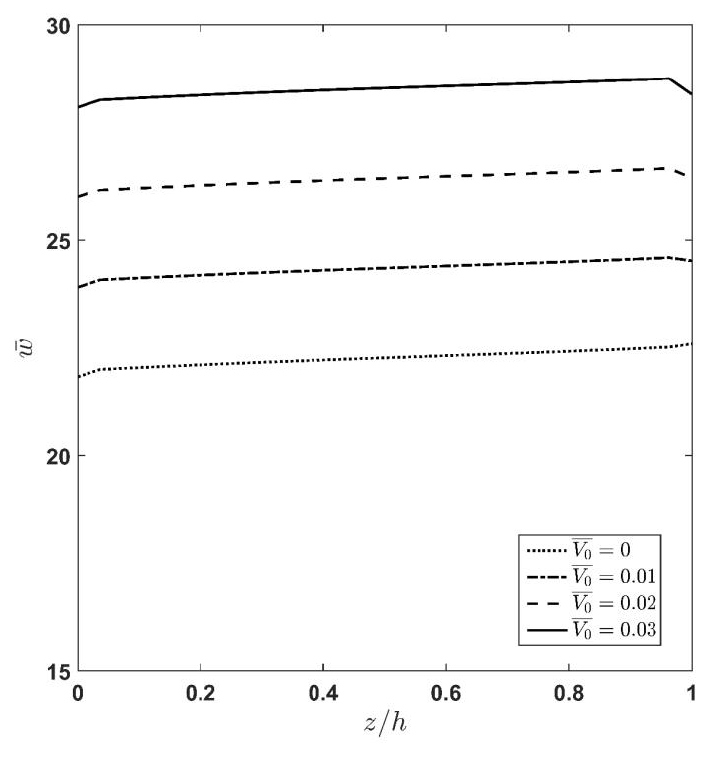
Figure 8. Influence of applied voltage variation of longitudinal normal stress, transverse shear stress, and transverse displacement along the thickness direction.